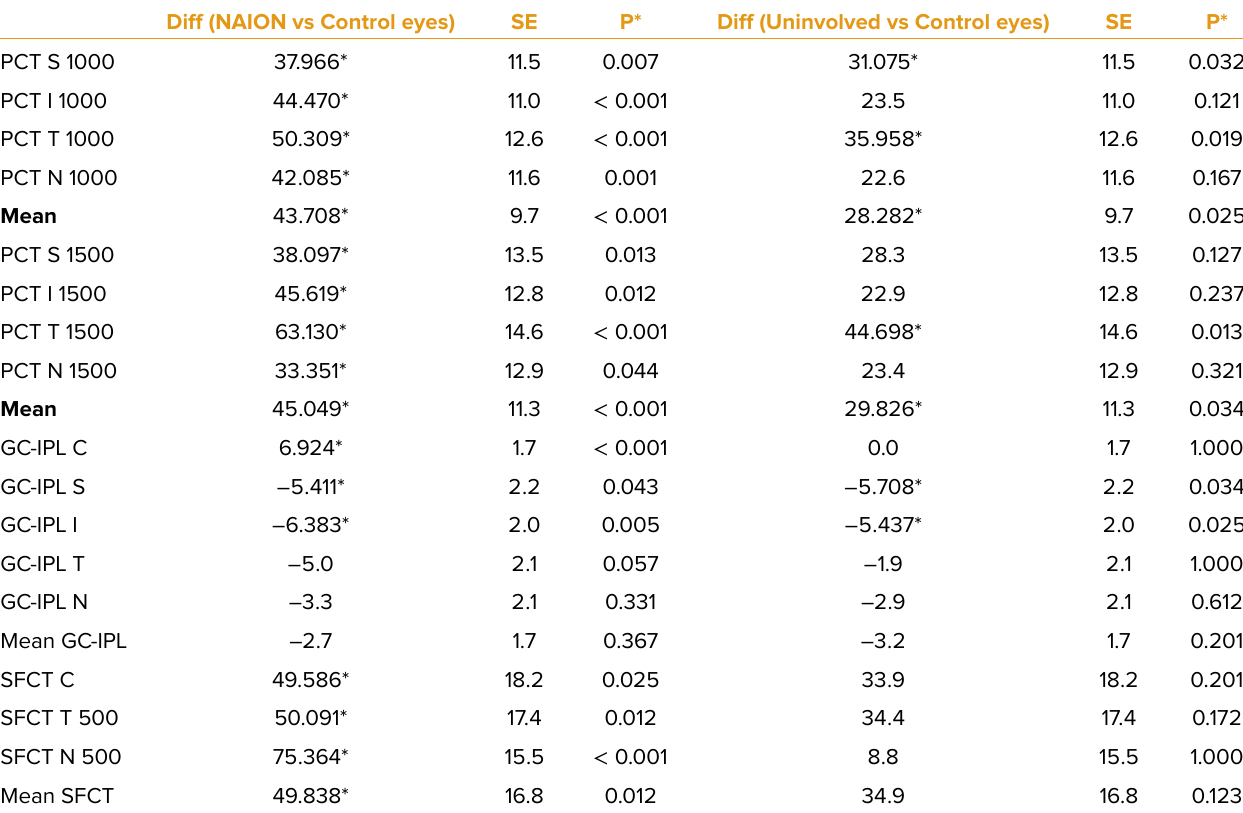
Table 5. PCT, GC-IPL, and SFCT values adjusted for hypertension and diabetes mellitus Diff (NAION vs Control